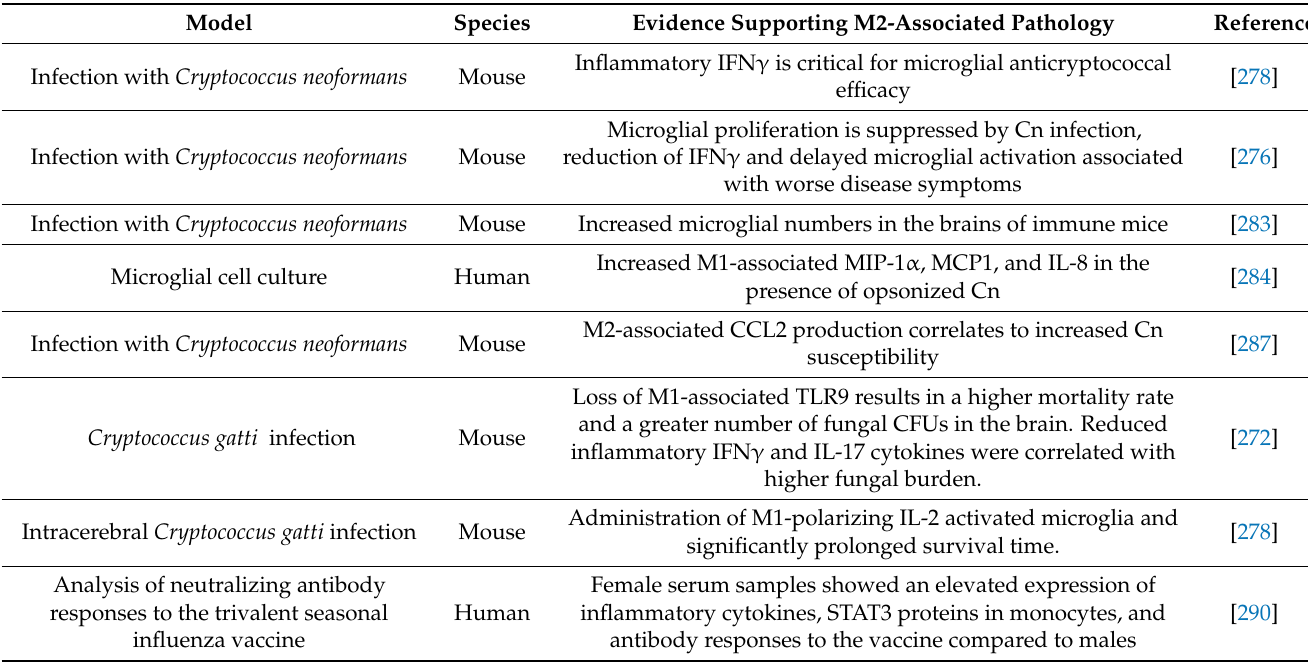
Table 5. M1 inflammatory responses promote recovery from